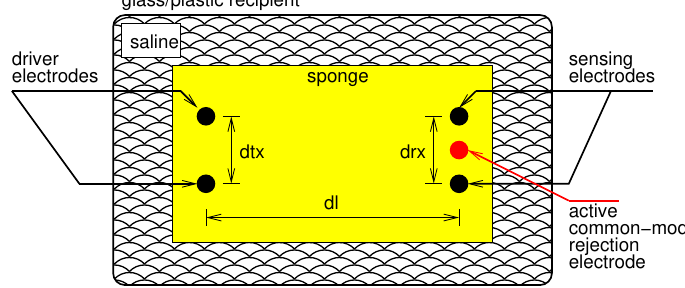
Figure 3. Phantom diagram showing electrode positions and